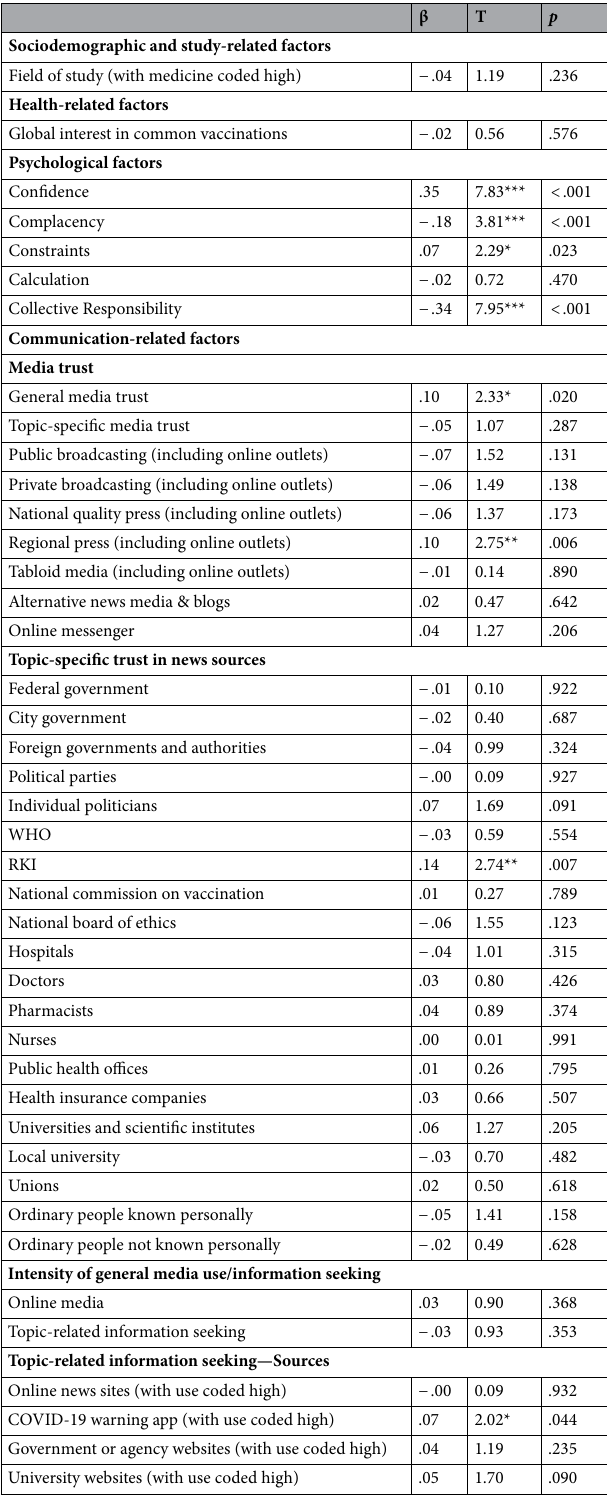
Table 3. Associations of sociodemographic, study-related, psychological, health-related, and communication- related factors with the intention to get vaccinated against COVID-19 among unvaccinated university students in the summer of 2021. Multiple linear regression analysis. F(42,291) = 21.32, p < .001, n = 334; Adjusted R 2 = .719; Cohen’s f 2 = 2.56. * p < .05; ** p < .01; *** p <